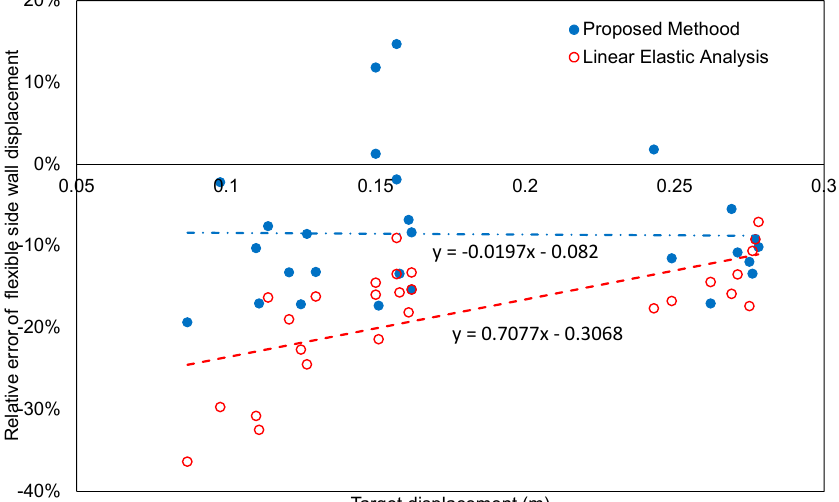
Figure 18. Comparison between the relative errors of the flexible side wall maximum displacement computed by the two methods with respect to the target displacement.